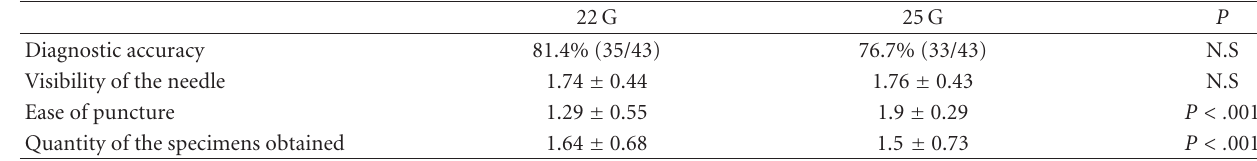
Table 3: Comparison of EUS-FNA with the 22-gauge and 25-gauge needles.